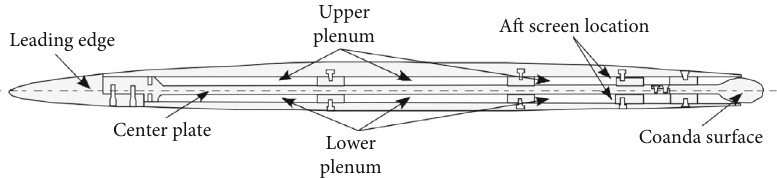
Figure 4: Elliptical airfoil with elliptical Coanda surface [29].